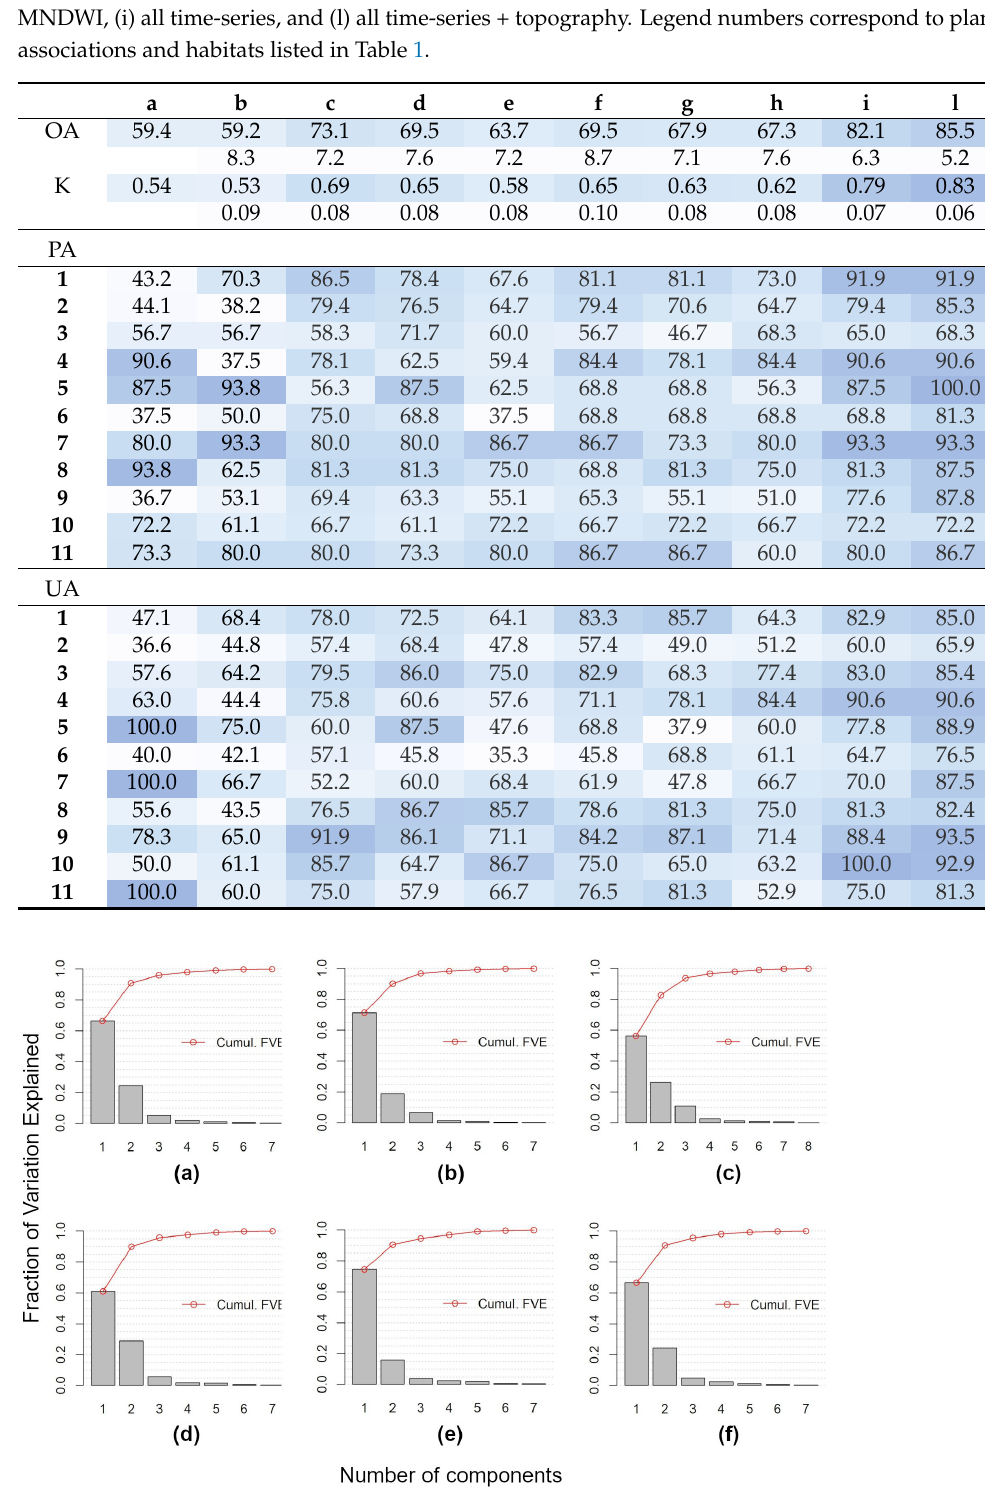
Figure A1. Number of components (and their fraction of variation explained) extracted by Functional Principal Component Analysis from Sentinel-2 time-series: ( a ) NDVI, ( b ) GNDVI, ( c ) MCARI, ( d ) NDRE, ( e ) MNDWI, and ( f ) NDWI. Cumul. FVE is the cumulative Fraction of the Variance